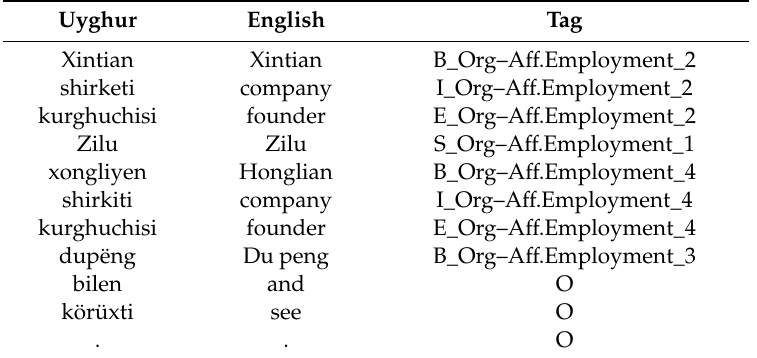
Table 2. Annotations adopted for an example Uyghur sentence to facilitate relation extraction.